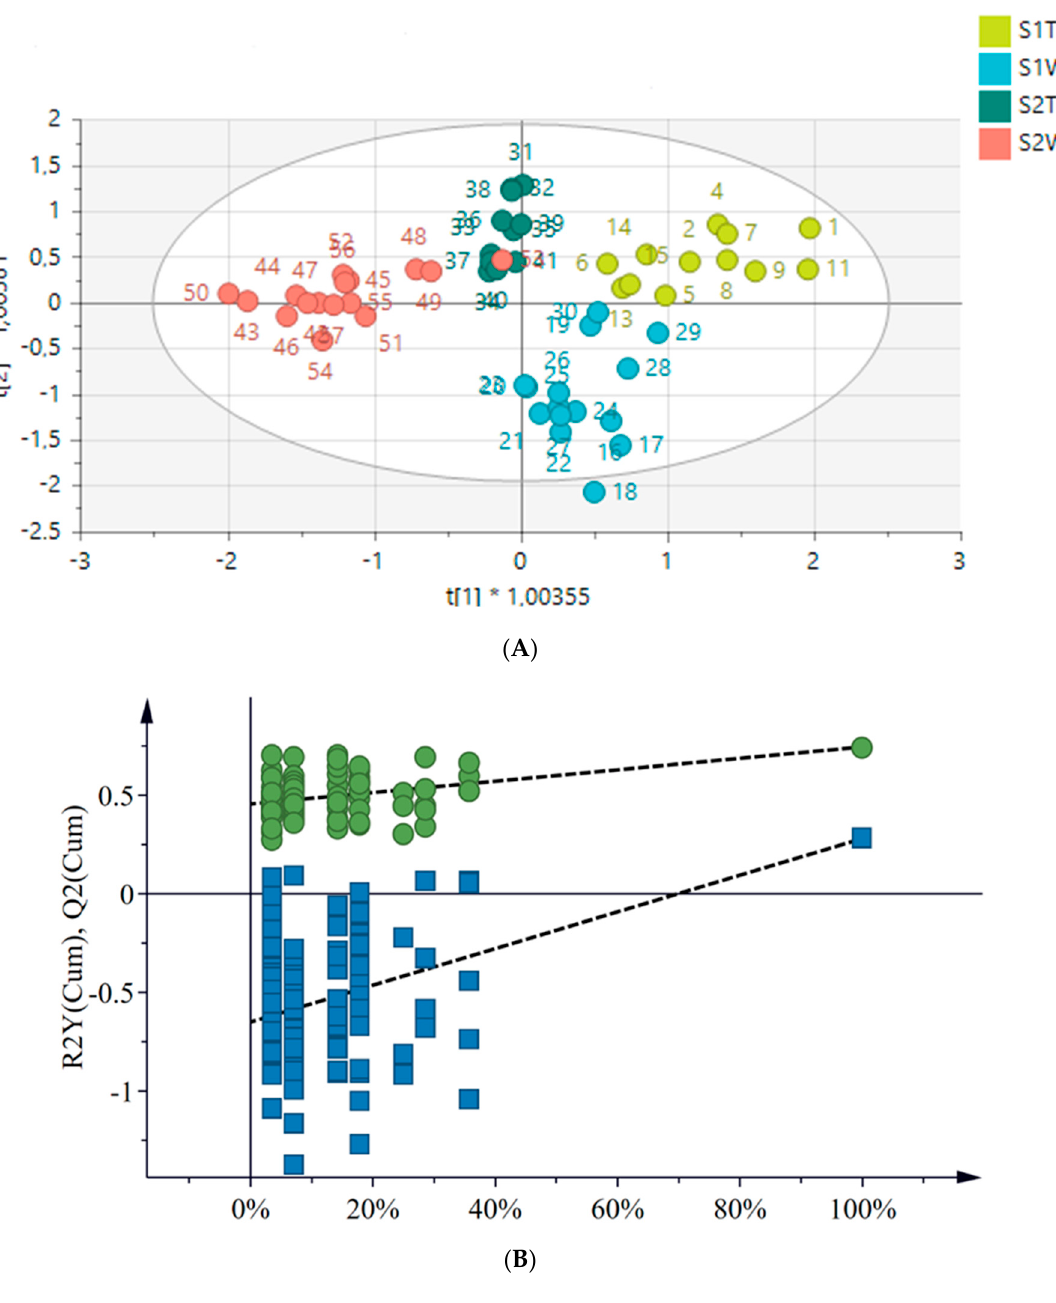
Figure 2. ( A ) An OPLS-DA score scatter plot showing the predictive ( x − axis) and orthogonal ( y − axis) components of H. aureonitens leaves and stems during spring and autumn at Telperion and Wakefield. R 2 X = 0.905, R 2 Y = 0.727 and Q 2 = 0.384. S1T = spring, Telperion; S1W = spring, Wakefield; S2T = autumn, Telperion; S2W = autumn, Wakefield. ( B ) The response permutation test ( n = 100) for the OPLS-DA model corresponding to y -axis intercepts. R 2 = (0.0, 0.46) and Y 2 = (0.0, − 0.65).